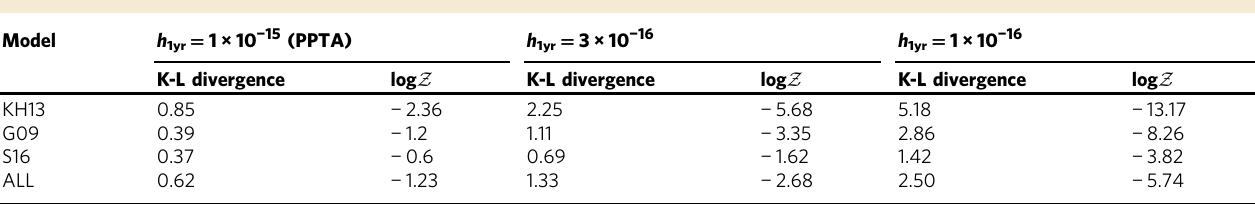
for models ALL and S16 we fi nd e − 1.23 = 0.3 and e − 0.6 = 0.55,